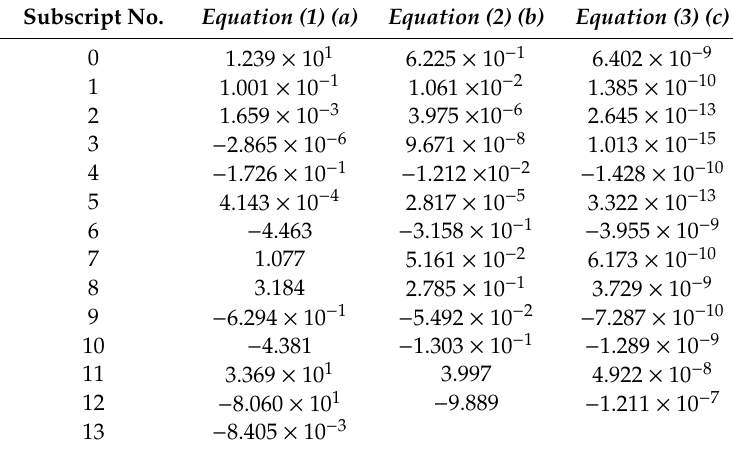
Table 4. Parameters of the three